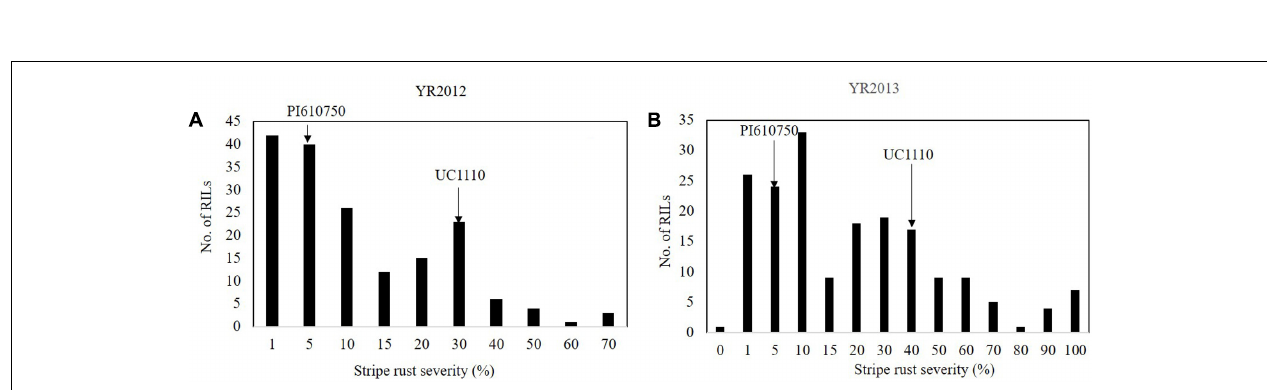
FIGURE 4 | Frequency distributions of UC1110/PI610750 recombinant inbred lines (RILs) for final stripe rust severity in field trials (A) at Toluca in 2012 (YR2012) and (B) at Toluca in 2013 (YR2013). The stripe rust severities for PI610750 and UC1110 are indicated by arrows.